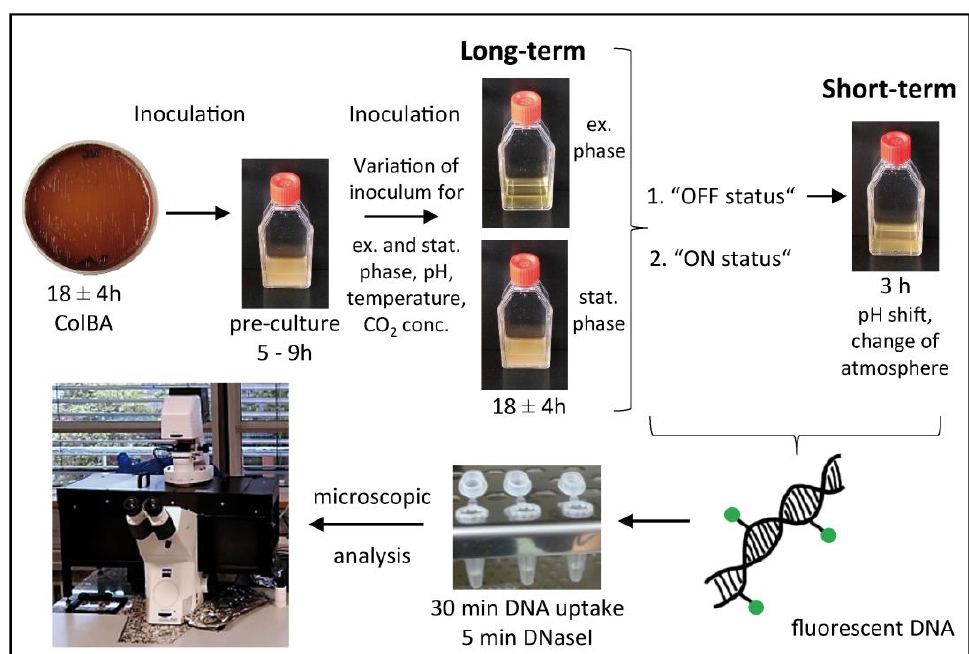
Figure 3. Schematic overview of the experimental setup of the single cell assay. All cells grown on ColBA plates were pre-cultured in Bolton broth for 5–9 h to stationary phase. A subculture was prepared with variation of inoculum (to reach exponential or stationary phase), pH, temperature, CO 2 concentration and incubated microaerobically for 18 ± 4 h. These cells were analyzed in the framework of the “long-term” setup. Cultures (from the “long-term” setup) in “OFF status” were challenged for 3 h by “short-term” pH elevation and/or atmospheric shift. After adding fluorescently labelled DNA and subsequent DNaseI digestion, bacteria were analyzed by fluorescence microscopy. Ex. phase, exponential phase culture with OD 600nm of 0.1–0.5; stat. phase, stationary phase